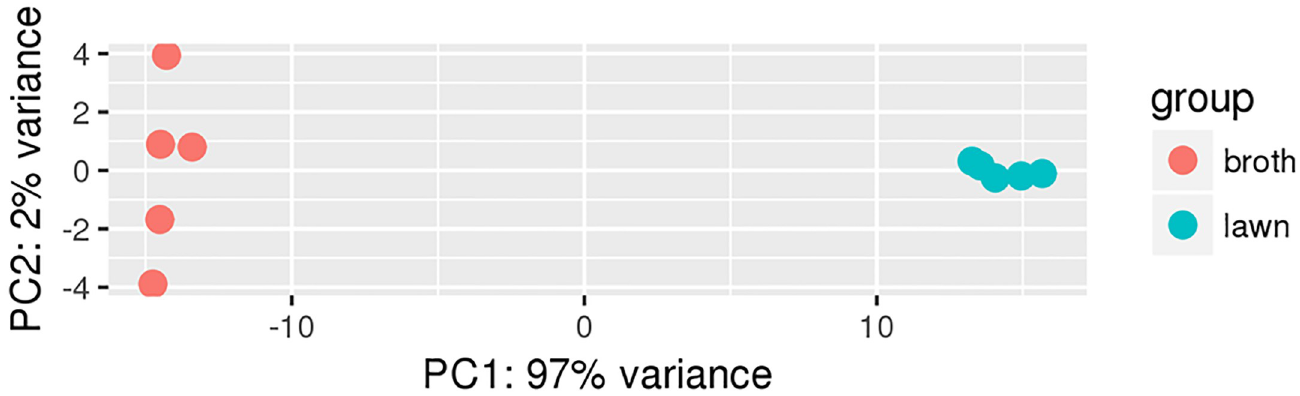
Fig 1. Principal component analysis (PCA) plot evaluating the variance between samples. The transcriptome of broth grown (orange) and agar grown (blue) G . parasuis replicates clustered within a treatment group (growth medium). The majority of variance detected was associated with differences between growth medium utilized.